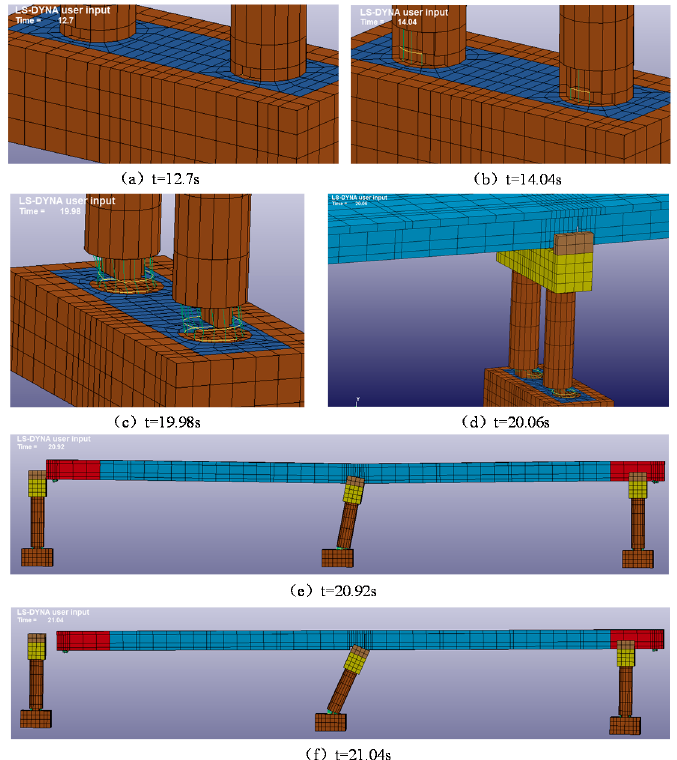
Figure 21. Longitudinal collapse mode of the CFVD system under the Chi-chi wave.